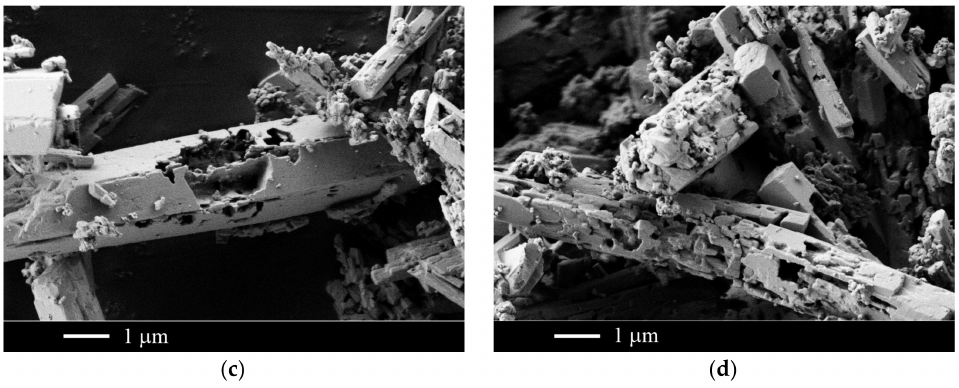
Figure 3. Scanning electron microscopy (SEM) images of the specimens in the NaF–YF 3 system synthesized at 320 ◦ C, ratios of Y(NO 3 ) 3 :NaF:NaNO 3 starting materials: 11:30:59 ( a ) (sample 1); 9:39:52